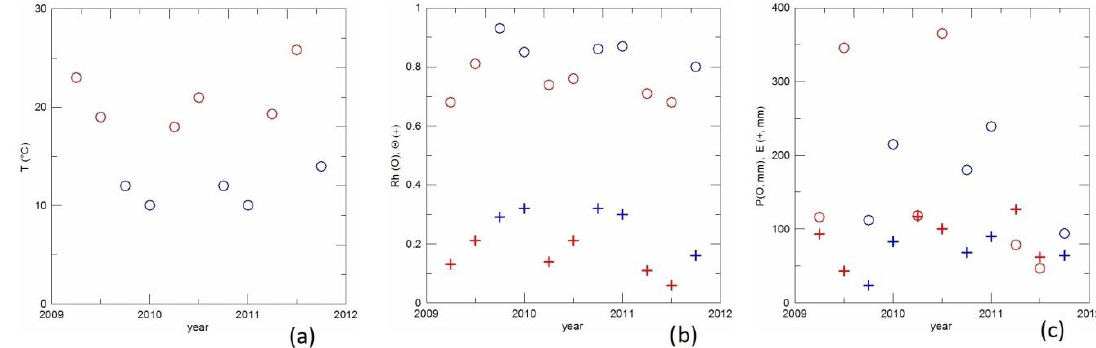
Figure 3. Hypsometric map of Salento Peninsula and locations of the ISAC-CNR base, LE-PS17 and BR-NM2 wells and Manduria and Corigliano rain gauges; elevation in meters a.s.l. (mod. from http://www.sit.puglia.it/portal/portale_cartografie_tecniche_tematiche/Cartografie%20Tematiche/DTM).